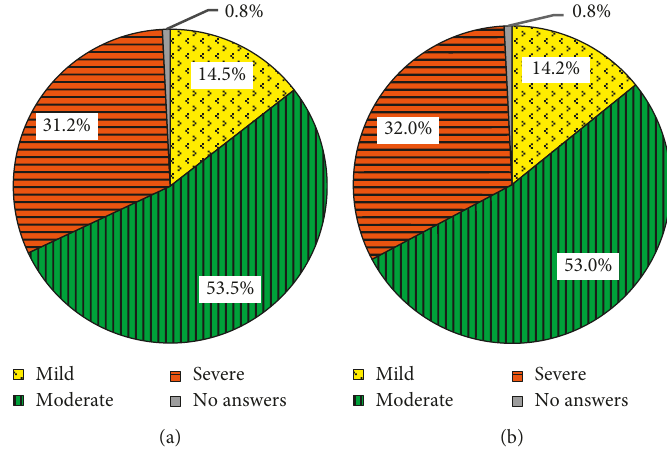
Figure 1: Intensity of rheumatic pain: on the day before admission (Q6) (a); most frequently felt (Q7) (b).